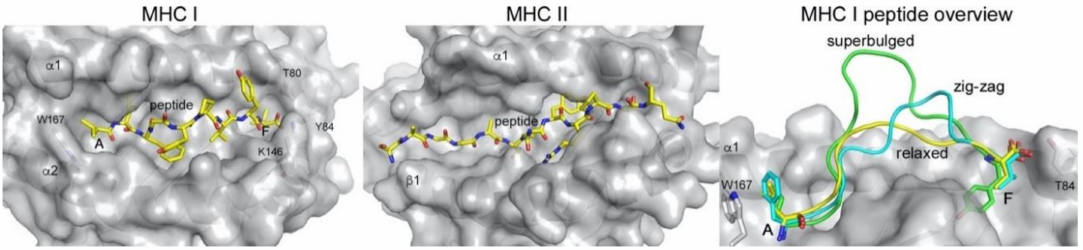
Figure 2. Peptide presentation by MHC class I (MHC I) and class II (MHC II). The peptide (yellow sticks) is confined between the major binding pockets A and F in MHC I (PDB 1DUZ), while it laterally extends outside the binding platform in MHC II (PDB 1K2D) due to the open groove architecture. Residues involved in closing the A and F pocket in MHC I are indicated. Right panel, MHCI can present longer peptides either bulging out in the middle of the binding groove (green, PDB 2AK4) or in a zig-zag fashion (cyan, PDB 5D9S), compared to the relaxed presentation of a 9-mer peptide (yellow, PDB 1DUZ). MHC molecules in the slightly transparent grey molecular surface, peptides as yellow sticks or as colored loops (right panel). All figures were prepared using PyMol (Schrodinger, LLC) and the indicated PDB